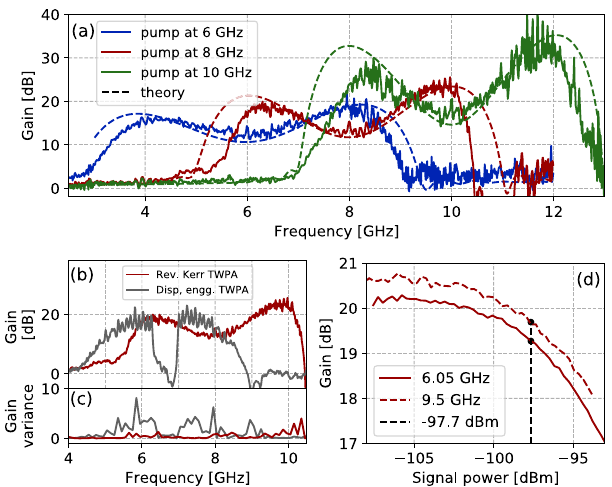
Fig. 3 Reversed Kerr gain. a Gain pro fi le of same device pumped at 6, 8, and 10 GHz and tuned to operate at external magnetic fl ux Φ ext / Φ 0 = 0.5. Dashed lines indicate the gain predicted by the theoretical model. b , c Comparison of gain and gain variance of reversed Kerr TWPA pumped at 8 GHz to TWPA with phase matching implemented using stop band engineering 10 pumped to 6.635 GHz. The variance has been evaluated over bins of 100 MHz. d Gain compression as a function of input signal power when the reversed Kerr TWPA was pumped at 8 GHz, at signal frequencies on both side of pump with gain close to 20 dB. The 1 dB compression point at − 97.7 dBm is indicated with a dashed